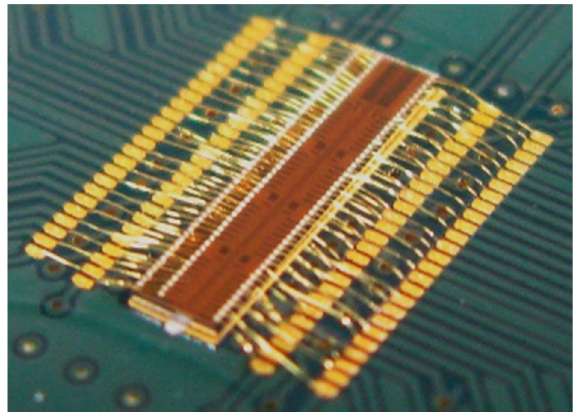
Figure 4. Integrated HV-CMOS LED driver chip, wire-bonded in a matrix-addressing configura- tion.